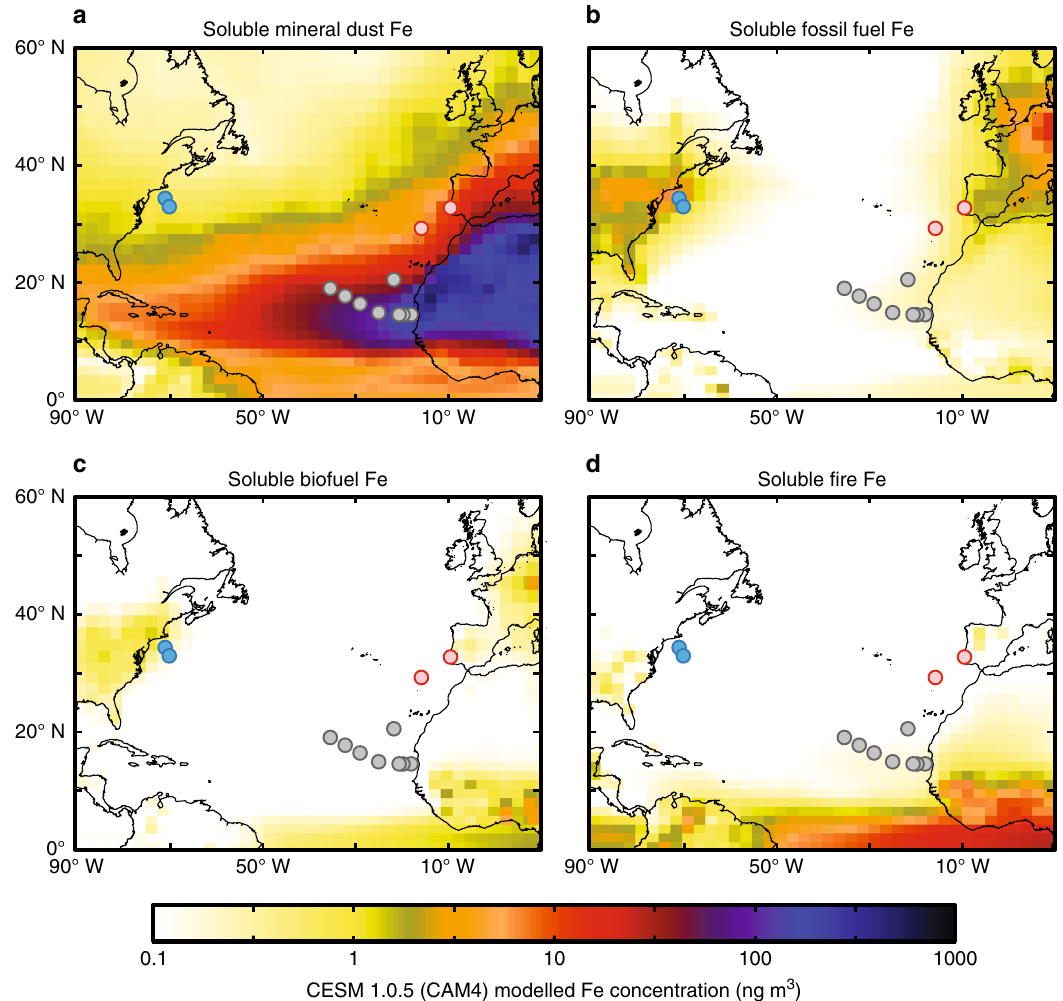
Fig. 4 Modeled aerosol Fe for the North Atlantic. CAM4 baseline model soluble aerosol Fe (combined October + November deposition) of aerosol Fe concentration for crustal mineral dust, fossil fuel, biofuels, and fi re, with sampling locations in this study shown. Panels show soluble aerosol Fe concentration output for a mineral dust, b fossil fuel, c biofuel, and d fi re from the Community Earth System Model (CESM 1.0.5) with the Community Atmosphere Model (CAM4) bulk aerosol model, using intermediate complexity soluble atmospheric processing (baseline CAM4 scenario) 49,50 . GA03 sampling locations are color coded as in Fig.